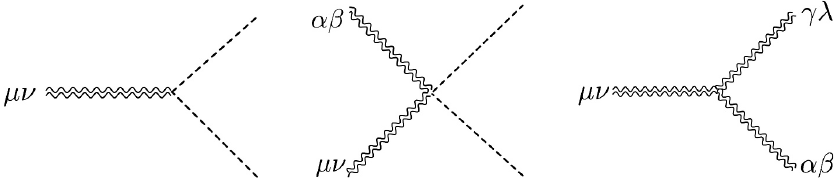
Figure 2 . Graviton-matter three-point (left) and the graviton-matter four-point (middle), graviton three-point (right) vertex functions: the double wiggly lines corresponds to graviton h µν , while the scalar field φ is described by dotted